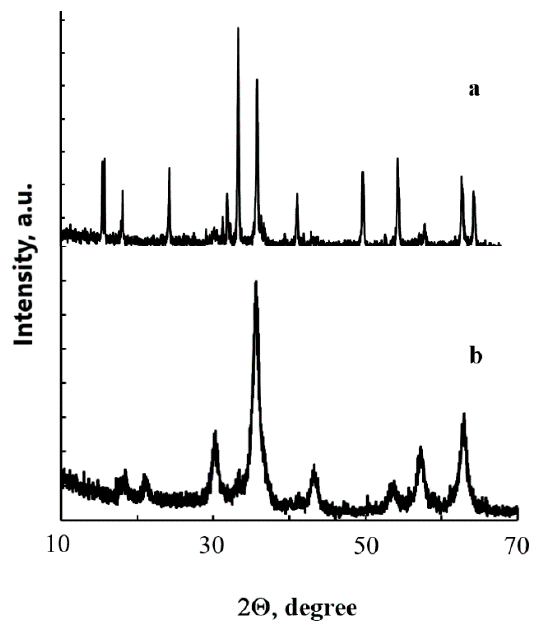
Figure 1. XRD of the synthesized powders α -Fe 2 O 3 ( a ) and Fe 3 O 4 ( b ).